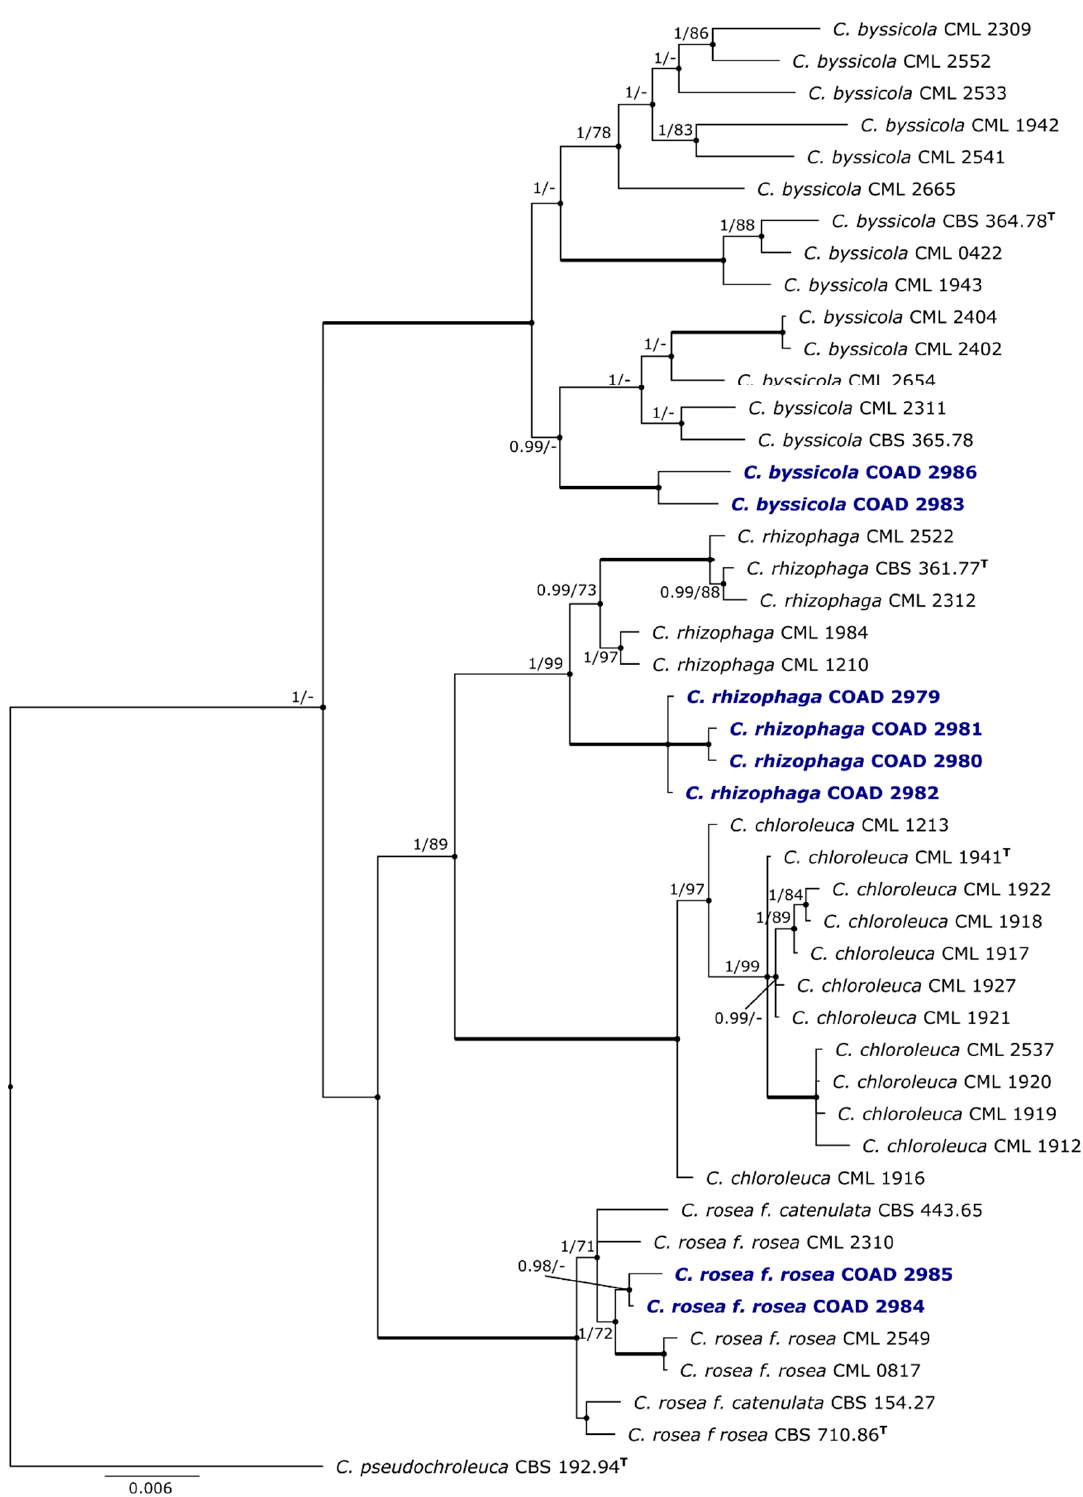
Figure 1. Bayesian inference (BI) based on analysis of a combined data set of ACL1, RPB1, TEF1- α and TUB sequence data; the concatenated tree is rooted with Clonostachys pseudochroleuca (CBS 192.94 T ). Branches in bold represent a Bayesian posterior probability of 1.00 and100% bootstrap support for ML, with indicated values at the nodes; the sequences generated in this study are in blue; and branch lengths are proportional to distance. T: ex-type strain; the bar indicates the number of substitutions per